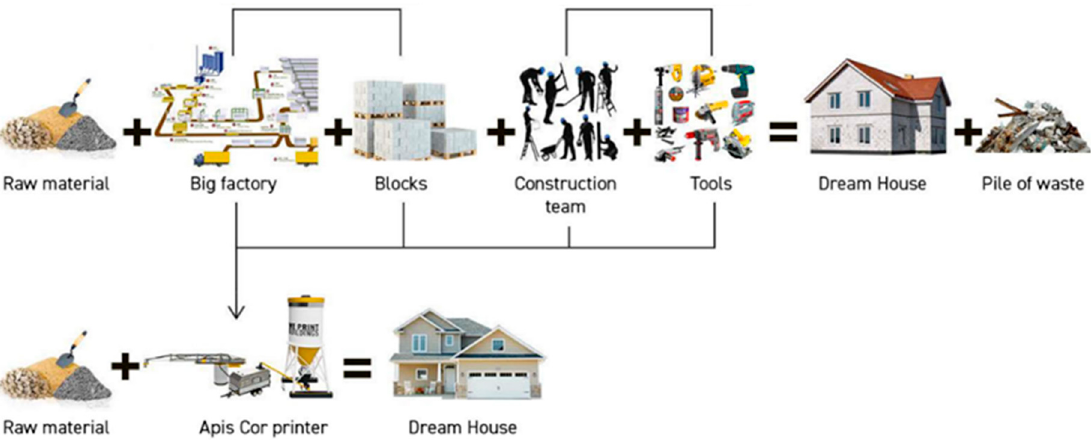
Figure 11. Additive manufacturing concrete building process (Reproduced from [59]).